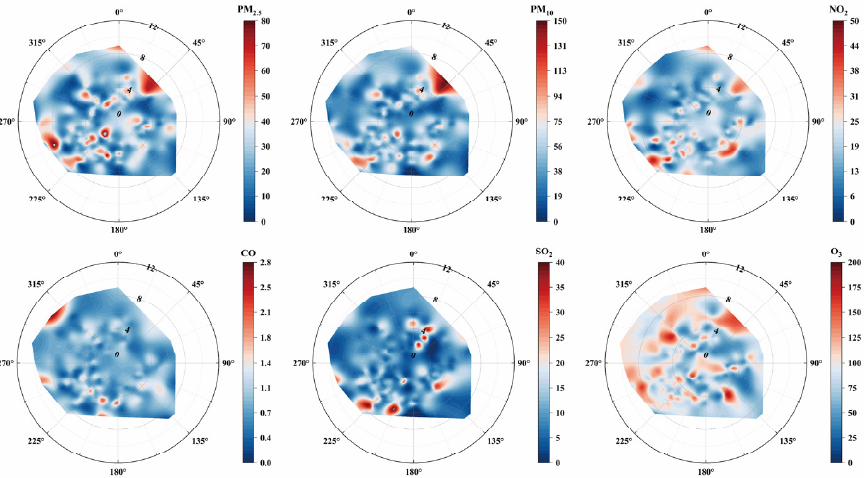
Figure 8. Polar plots of mean concentrations of main pollutant concentrations in the dry season.